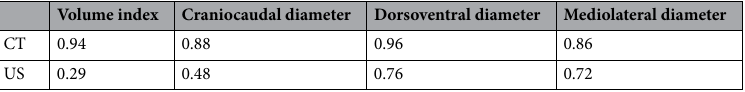
Table 2. Intraclass correlation coefficients for inter-rater variability.